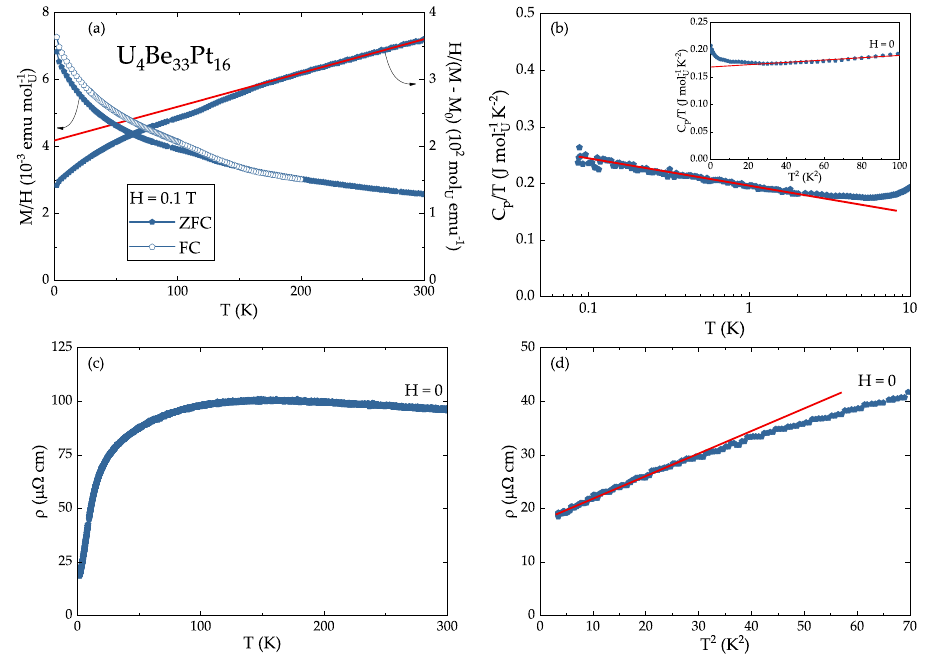
Figure 7. ( a ) Zero-field-cooled and field-cooled magnetic susceptibility (left axis) and inverse magnetic susceptibility (right axis) data for U 4 Be 33 Pt 16 in H = 0.1 T. The solid line is a Curie–Weiss fit to the inverse susceptibility. ( b ) Low-temperature specific heat data exhibit logarithmic divergence over more than a decade in temperature (red line). Inset: C p / T vs. T 2 with the solid line representing the fit from which the value of γ n was extracted. ( c ) Temperature-dependent resistivity data for U 4 Be 33 Pt 16 in H = 0 . ( d ) The low-temperature region of the ρ vs. T 2 plot.